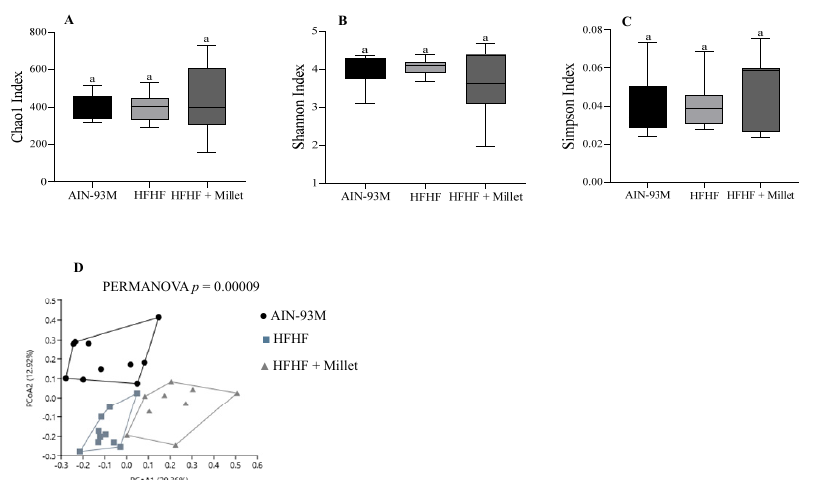
Figure 3. Microbial diversity of the cecal microbiome of different experimental groups after 10 weeks of the experiment. The α -diversity by: ( A ) Chao Index; ( B ) Shannon Index; ( C ) Simpson Index; ( D ) Measure of β -diversity using Bray–Curtis dissimilarity distances separated by two principal components (PCoA). Columns with different letters indicate significant differences by one-way ANOVA and post hoc of Newman–Keuls test ( p < 0.05). The top line of the box represents the upper bound of the data, the bottom line indicates the lower bound, and the middle of the box represents the median. PCoA was analyzed by the PERMANOVA test. Each dot refers to one animal. n = 10/group (AIN-93M, HFHF groups) and n = 9/group (HFHF + millet group). AIN-93M: standard diet; HFHF: high-fat high-fructose diet; HFHF + millet: HFHF diet + 28.63% of germinated millet flour.